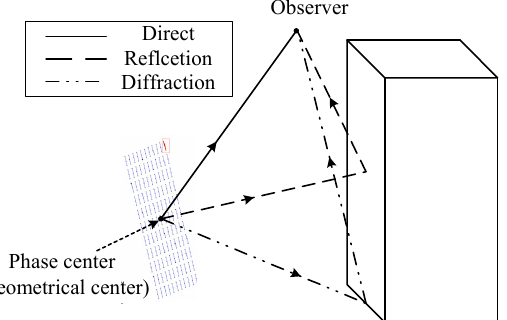
Figure 3. Fundamental ray types transmitted from the equivalent point of array antenna.